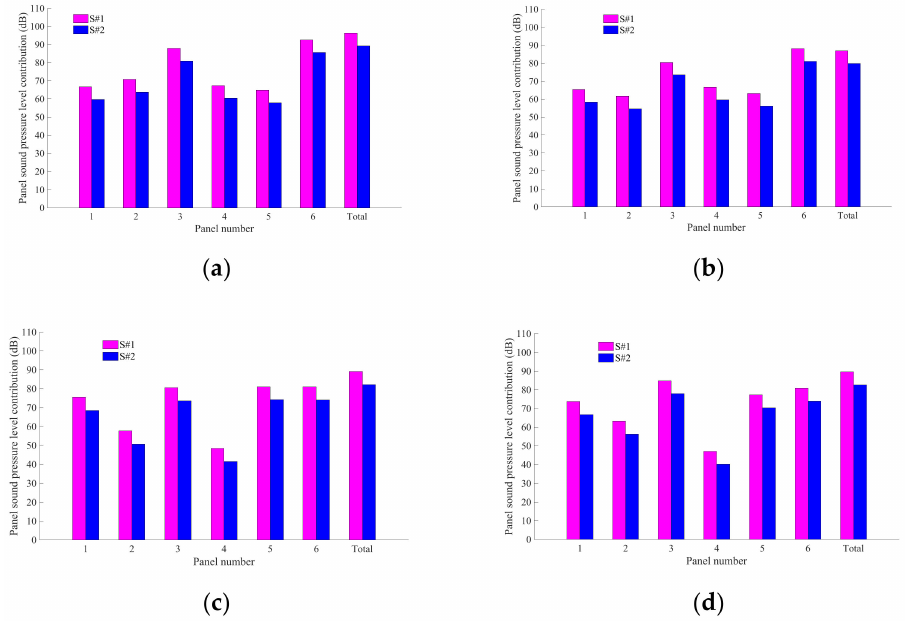
Figure 16. Panel sound pressure level contribution of each field point at 50 Hz; ( a ) field point 1; ( b ) field point 2; ( c ) field point 3; ( d ) field point 4.